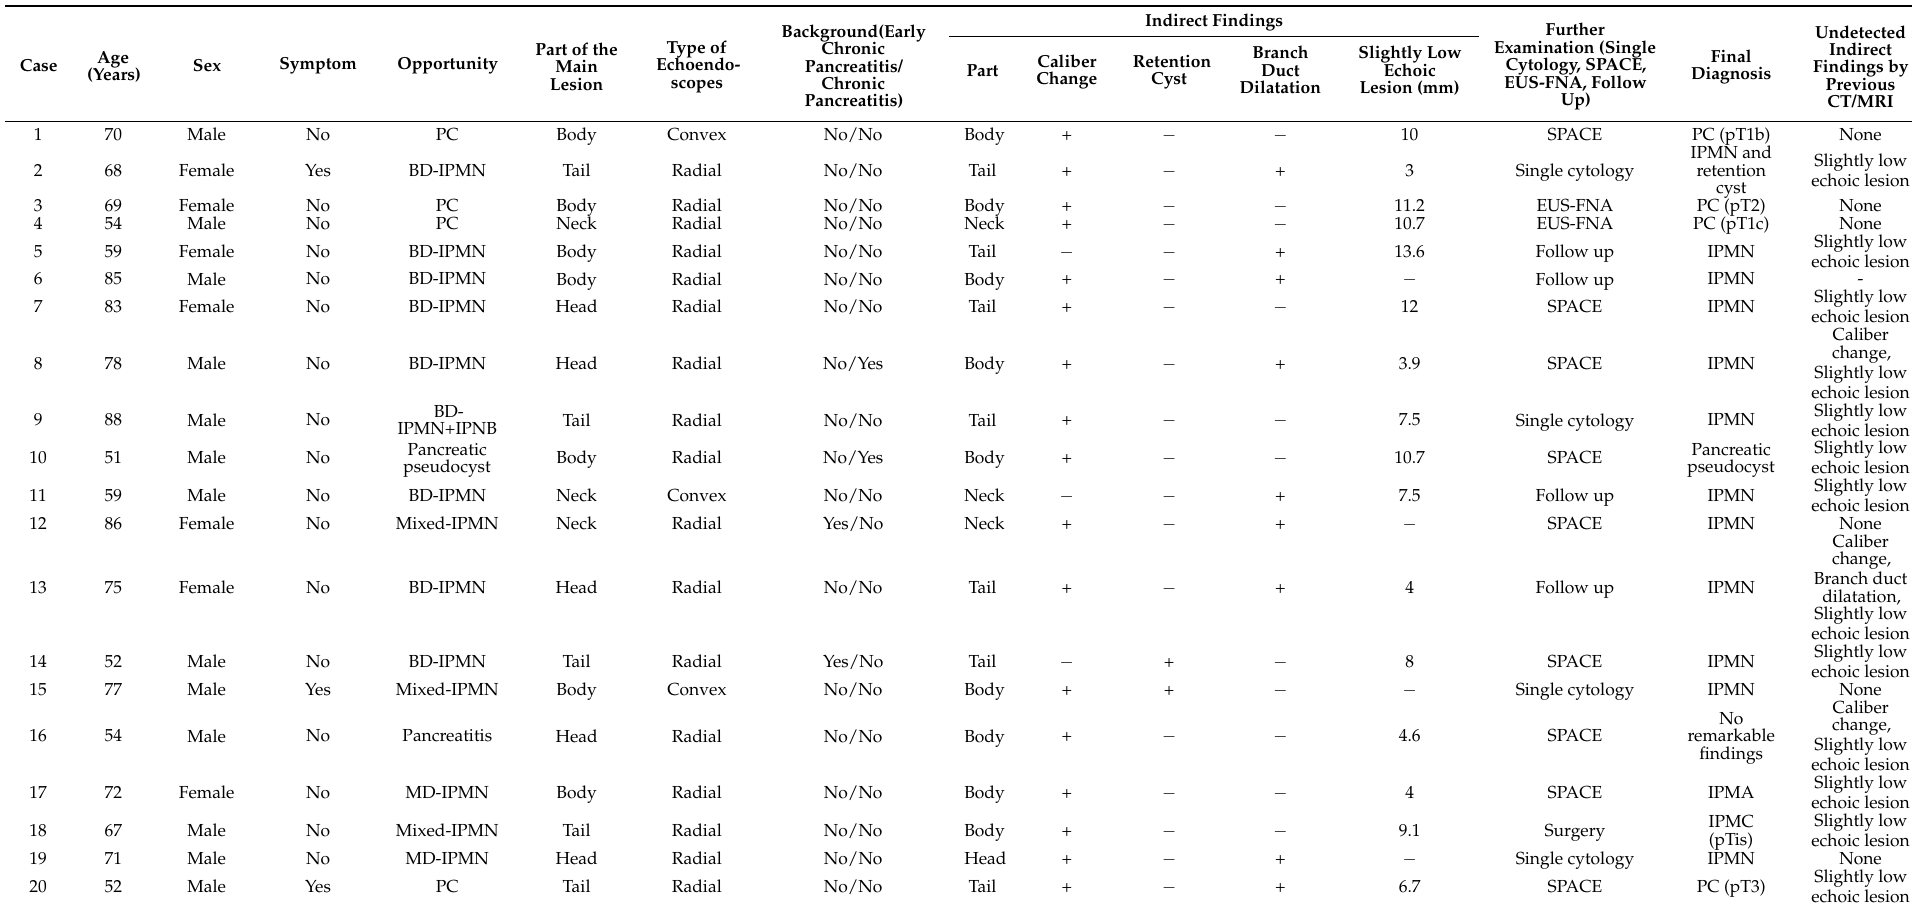
Table 5. Twenty cases with indirect